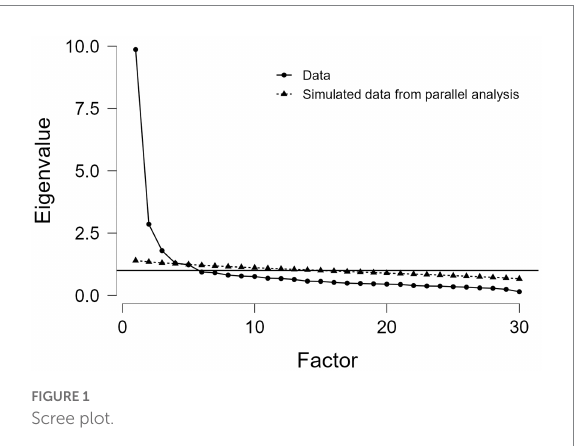
FIGURE 1 Scree plot.